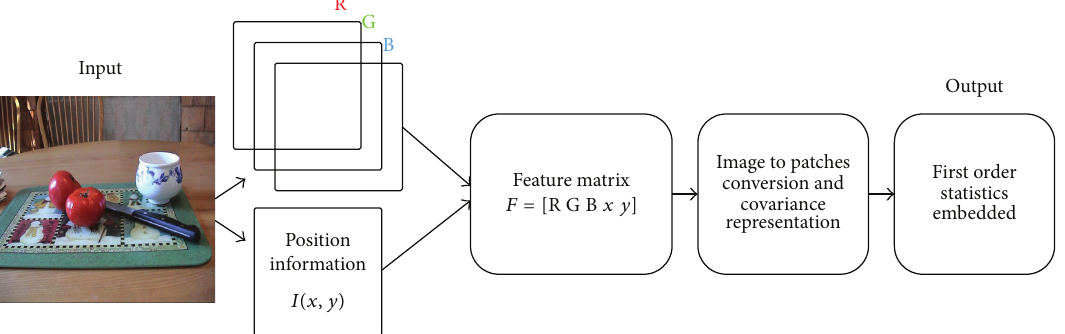
Figure 4: Nonlinear representation of an input